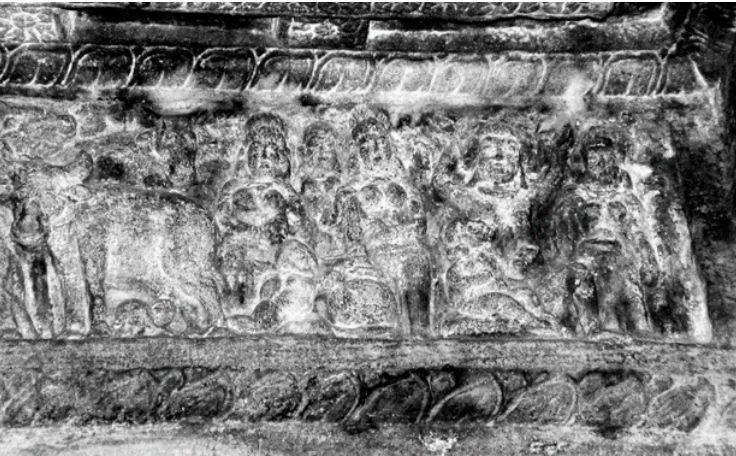
Figure 6. Exploits of the Young Kr.s.n.a (left to right): Churning with the “Butter-thief,” Slaying of P¯utan¯a, end of the sixth century. Interior lintel, Cave II at B¯ad¯am¯ı,